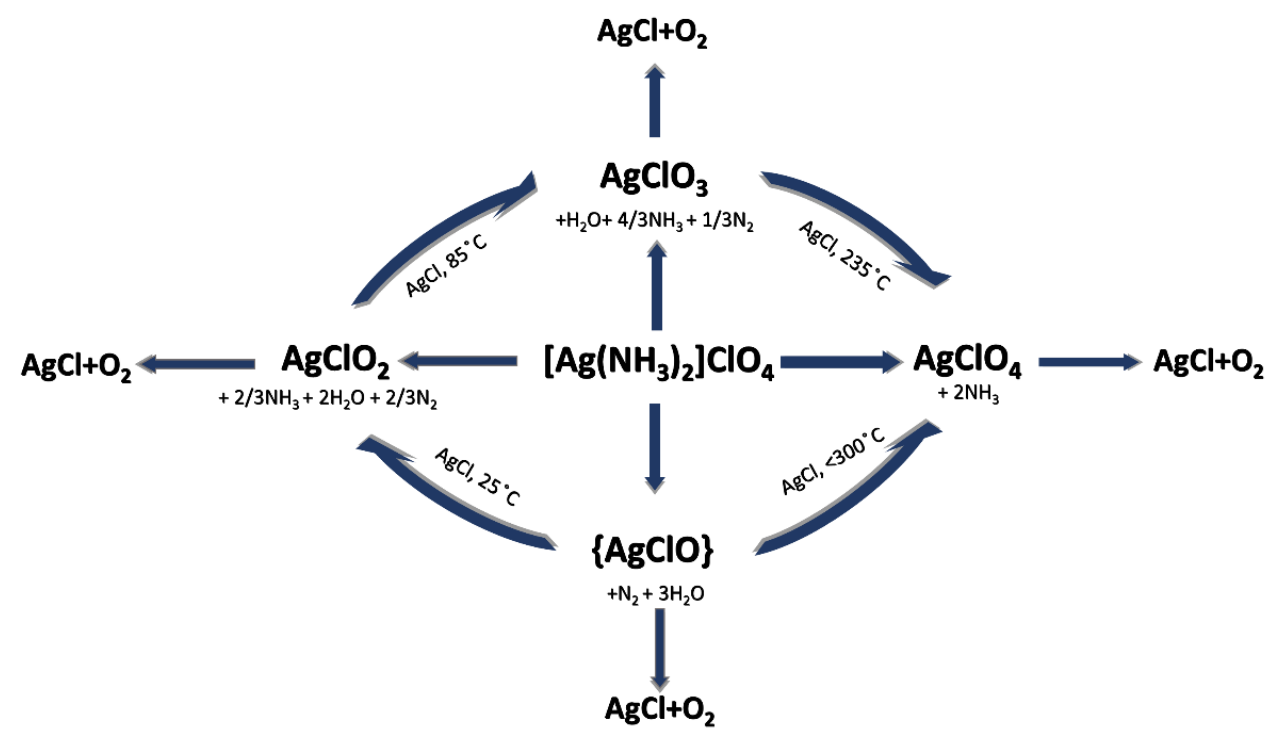
Figure 14. Summarized reaction scheme of compound 1 .